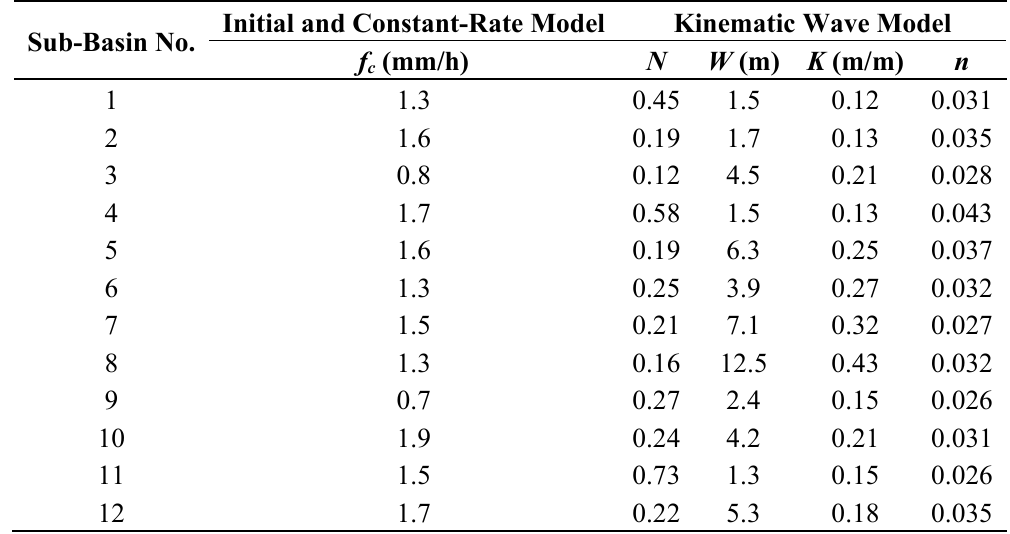
Table 4. The Calibration Result of the Run-off Volume and the Direct-runoff, Scheme І . Sub-Basin No.